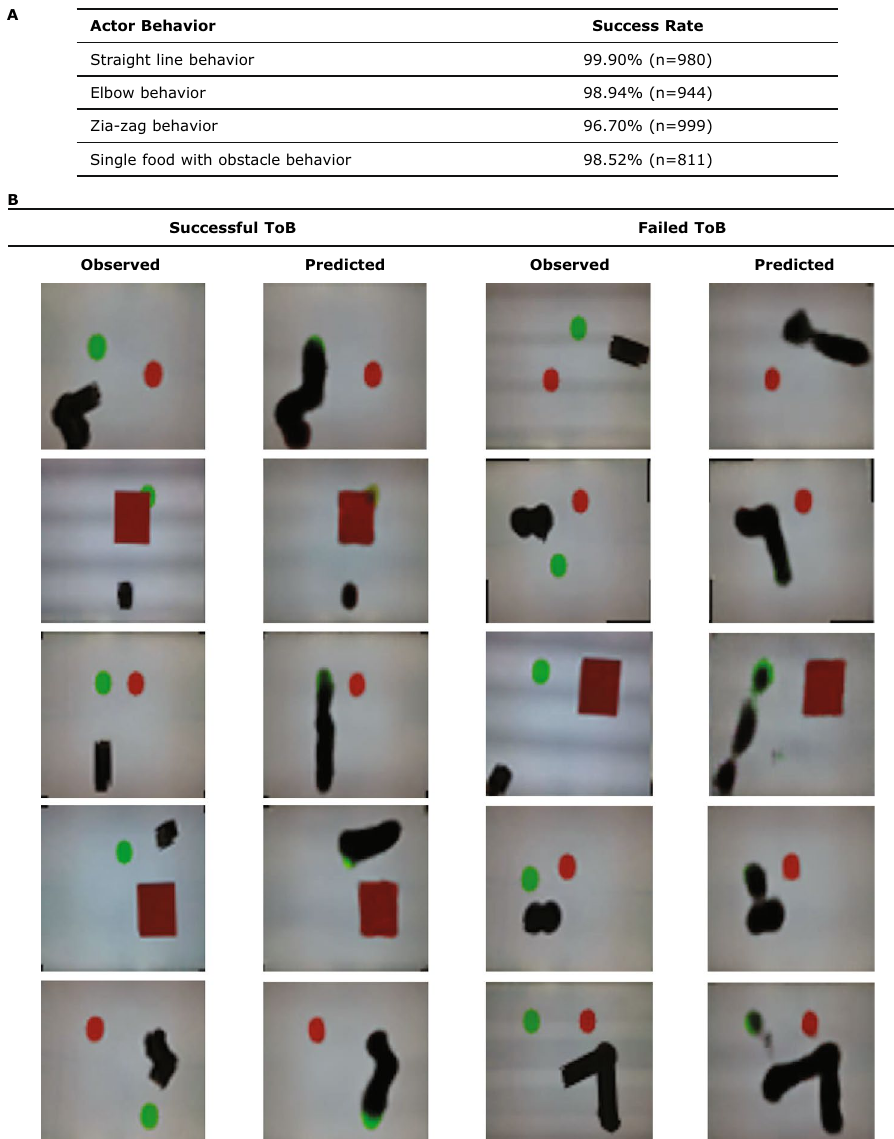
Figure 4. Success rate of observer AI and Physical scenes and outcomes envisioned by the observer. ( A ) We report the successful rate of the observer AI for each type of behavior during testing. Noted that all the behaviors of the actor robot are seen during training together and no other information is given except the single image frame. Our observer AI achieves a 98.5% success rate on average across all four types of behaviors of the actor robot. ( B ) The first column and the third column show some sample scenarios involving the actor robot, one or two green circles, and a square obstacle. The second and the fourth column show the outcome as envisioned by the observer. The left two columns (Success) show successful vision, whereas the right two columns (Failure) show failed